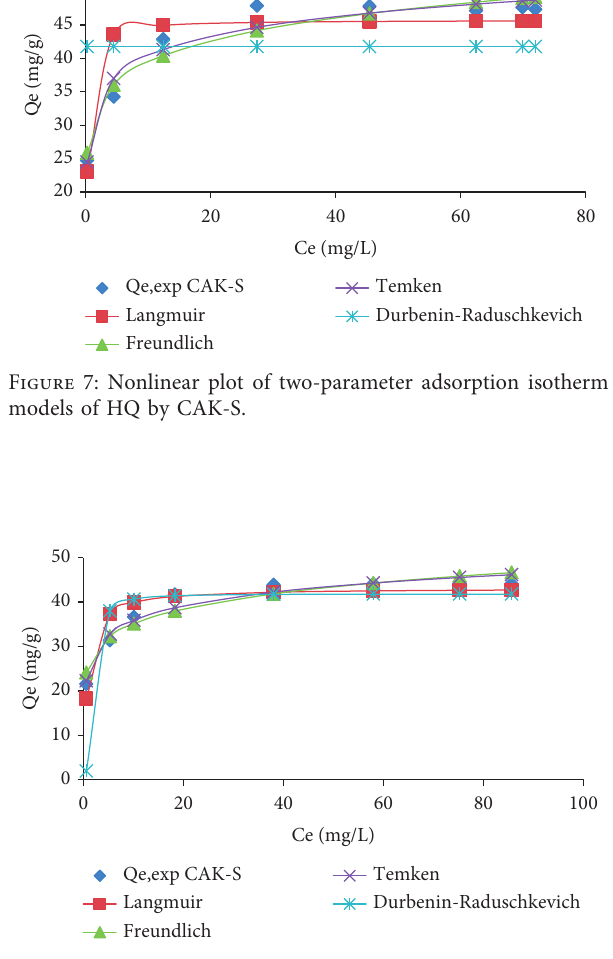
Figure 8: Nonlinear plot of two-parameter adsorption isotherm models of R by